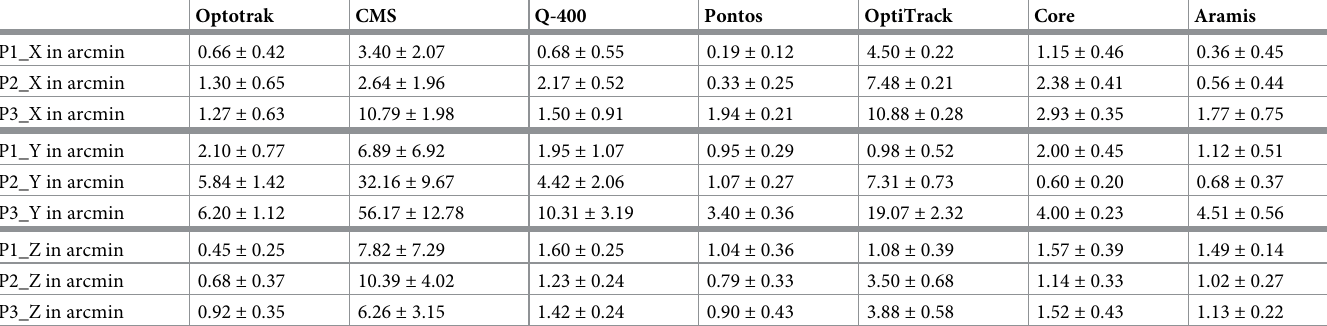
Table 7. Numerical rotational measurement errors of the seven measurement systems when using the manual reference device.